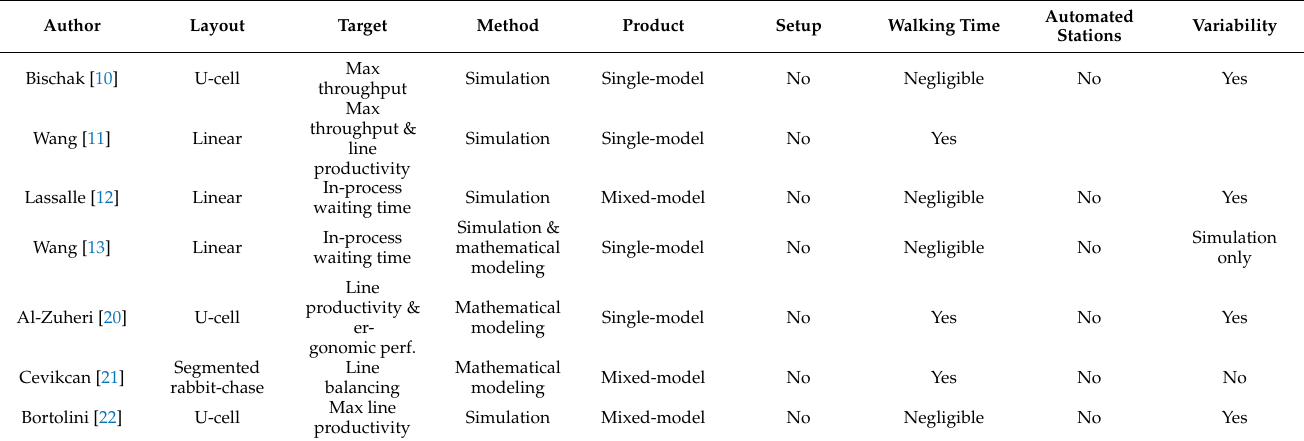
Table 1. Key aspects of selected research articles on walking-worker assembly lines